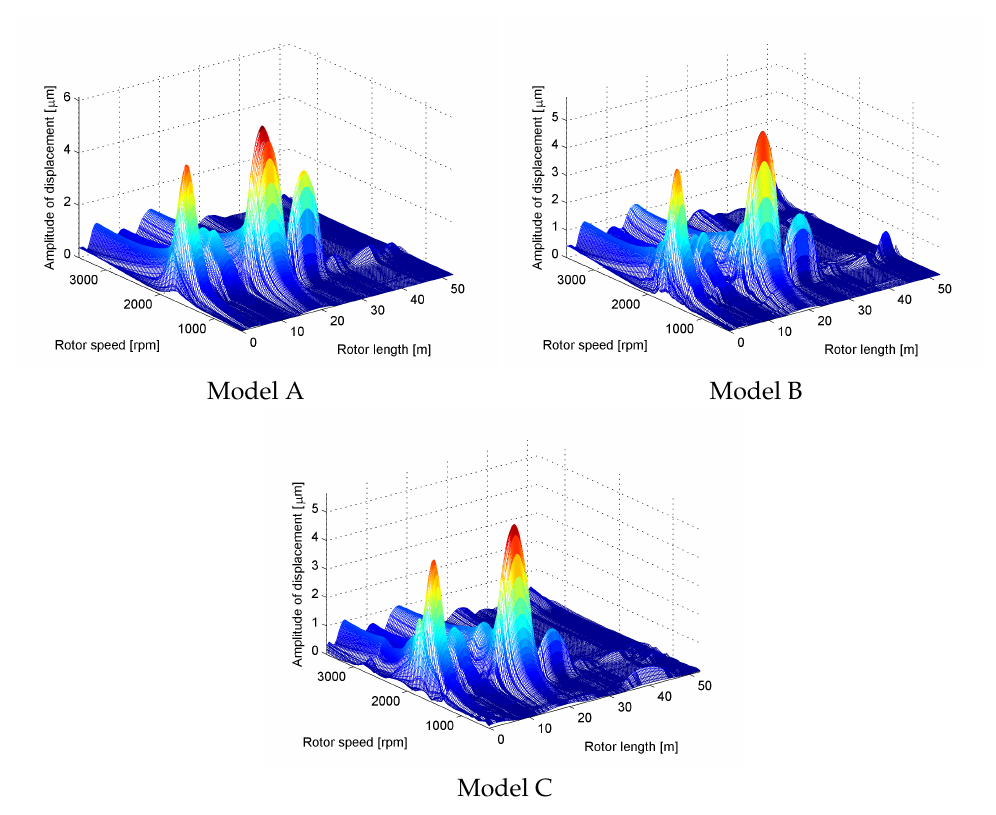
Figure 17. Absolute values of the rotor steady state complex amplitudes in the horizontal direction excited by the unbalance on all rotor